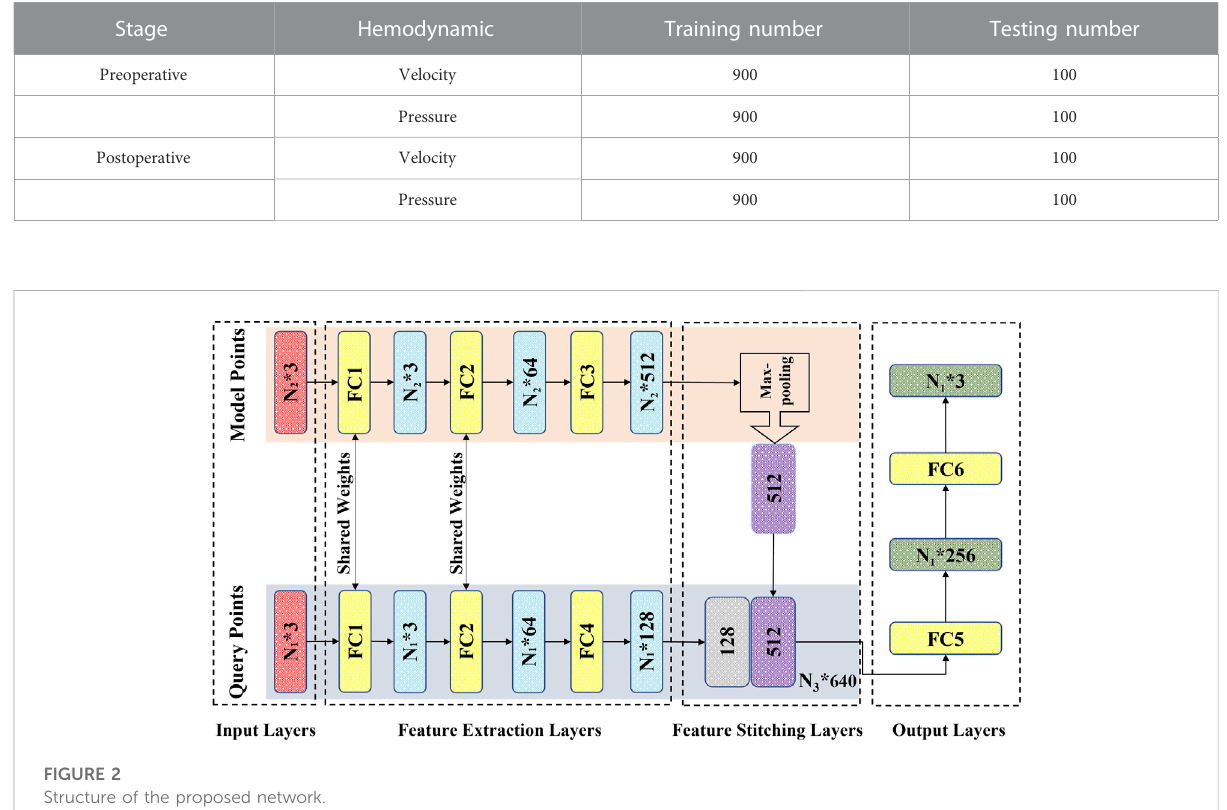
FIGURE 2 Structure of the proposed